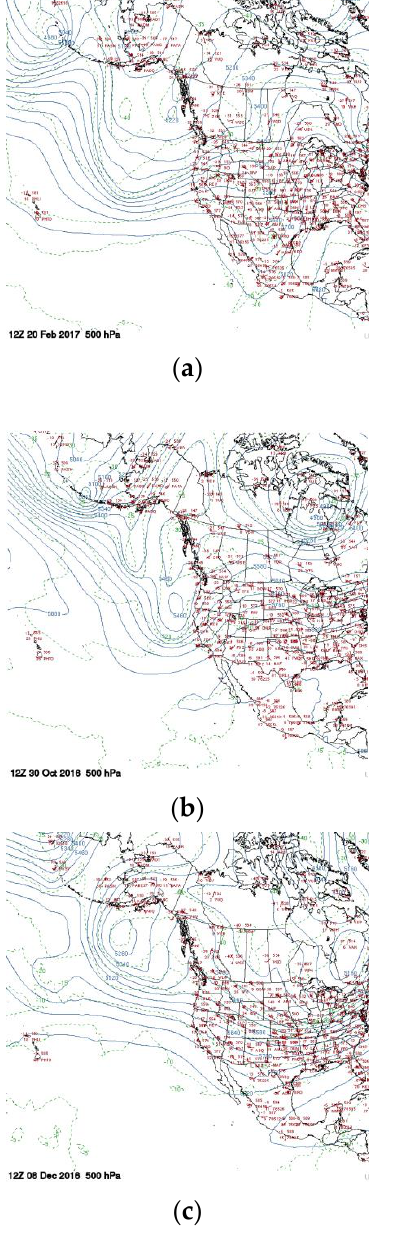
Figure 16. Left panels ( a – c ): 500 hPa height and thickness distributions at 12Z for 20 February 2017 (upper), 30 October 2016 (middle), and 8 December 2016 (lower). Right panels ( d – f ): same, but 200 hPa. Jet streaks are shaded.